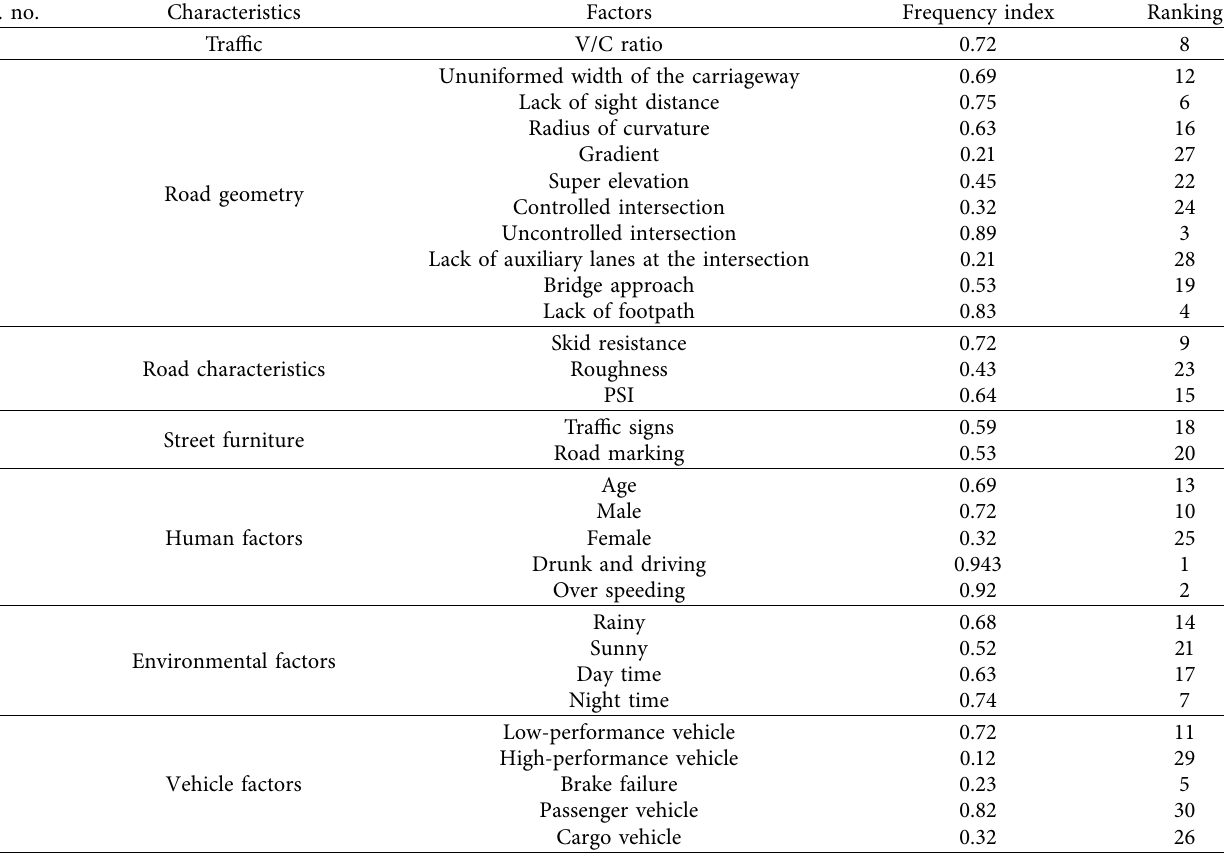
Table 4: Accident-causing factors, frequency index, and ranking.